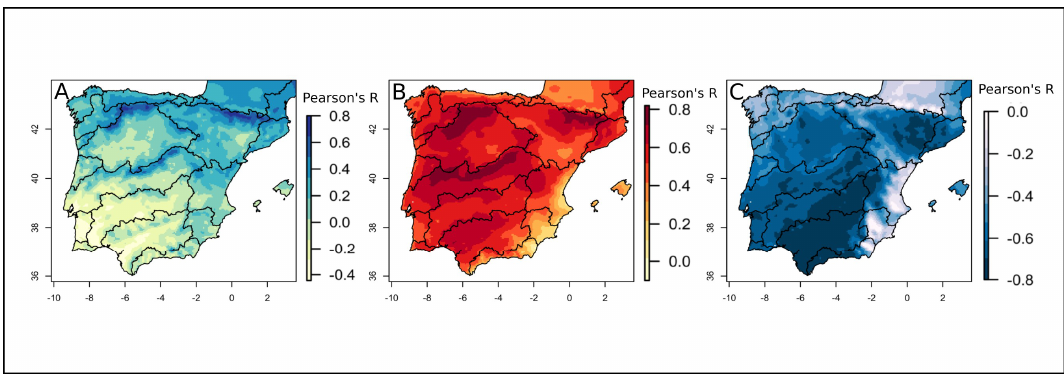
Figure 2. Pearson’s R values between the DJFM-NAO and minimum temperatures ( A ), maximum temperatures ( B ), and precipitation ( C ). The lines represent the boundaries of the main catchments in the Iberian Peninsula.